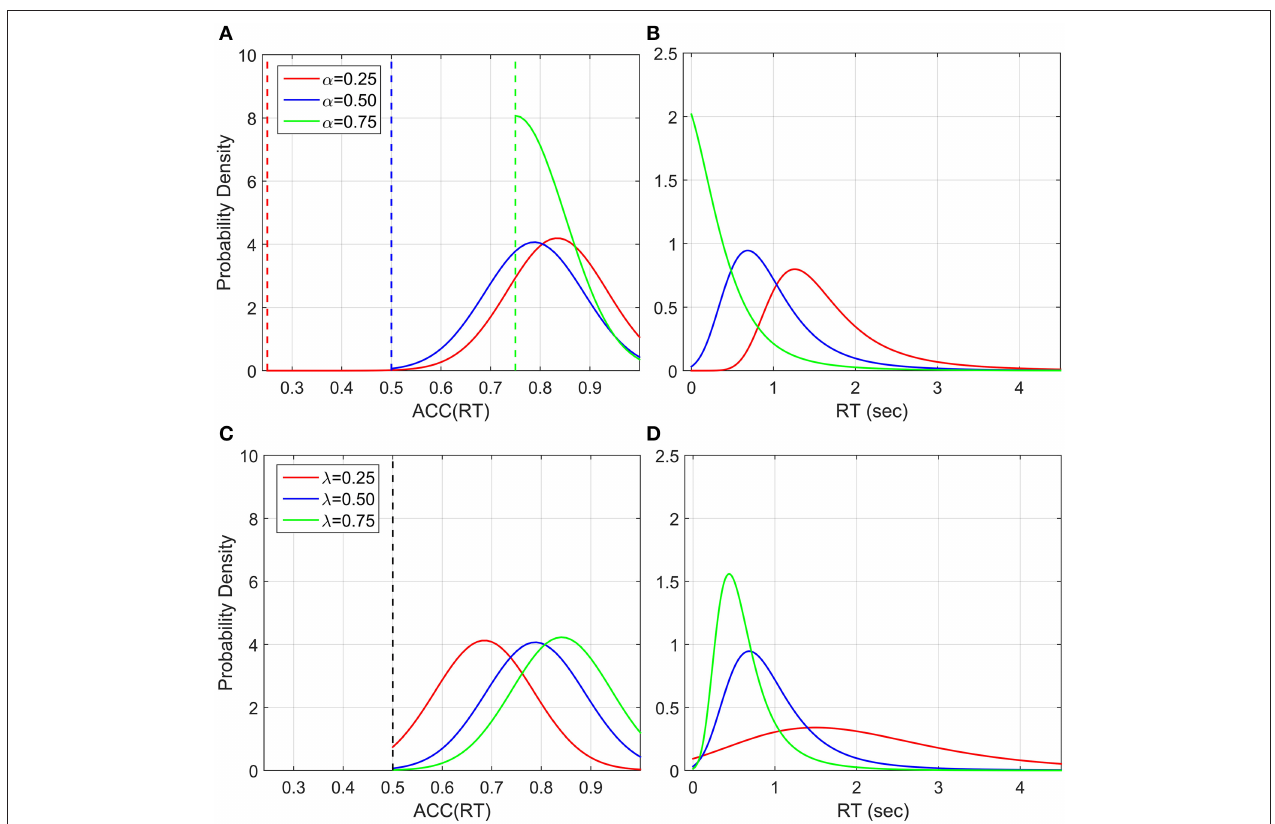
FIGURE 12 | Illustration of ACC ( RT ) distribution and corresponding RT distribution if ACC is normally distributed with truncation at 1 and at various α ’s. The mean of ACC ( RT ) is t * RRm and the standard deviation is set to 0.1 for illustration, which can be interpreted as a precision parameter. (A) ACC ( RT ) distributions for three α conditions with λ = 1. The dashed vertical lines correspond to the truncation point. (B) Corresponding RT distributions. By increasing α , which corresponds to decreasing the number of alternatives in a classic RT task, the distribution is less spread out and the mean decreases (faster responses). (C) ACC ( RT ) distributions for three λ conditions with α 0.5 and (D) corresponding RT distributions. By increasing λ , which corresponds to change the trial difficult in a classic RT = task, the distribution become less spread and the mean decreases (faste